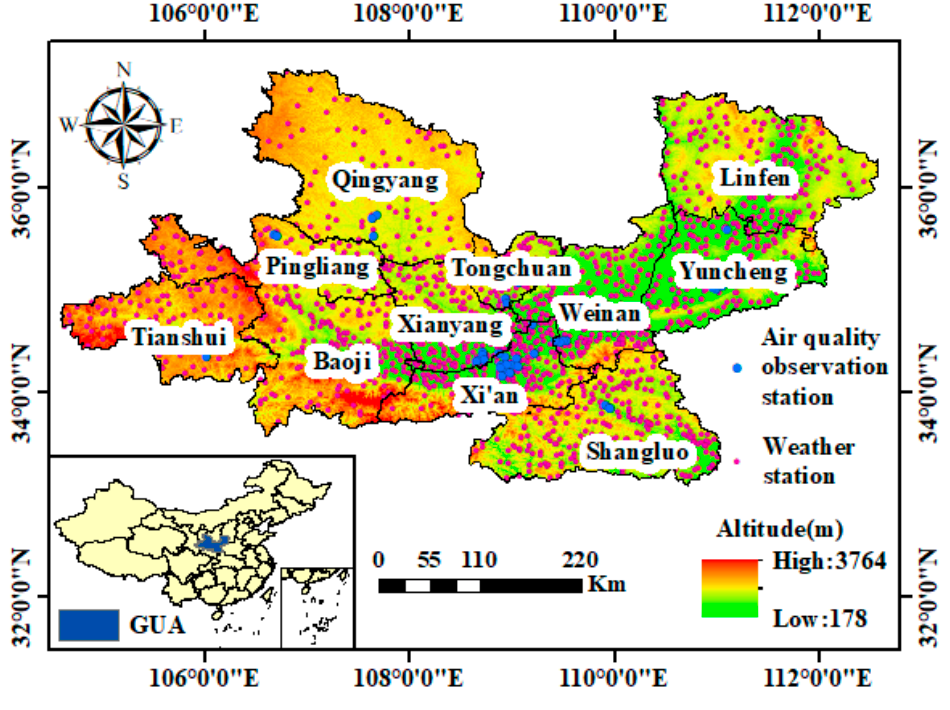
Figure 1. The study area and locations of the air quality observation stations and weather stations.